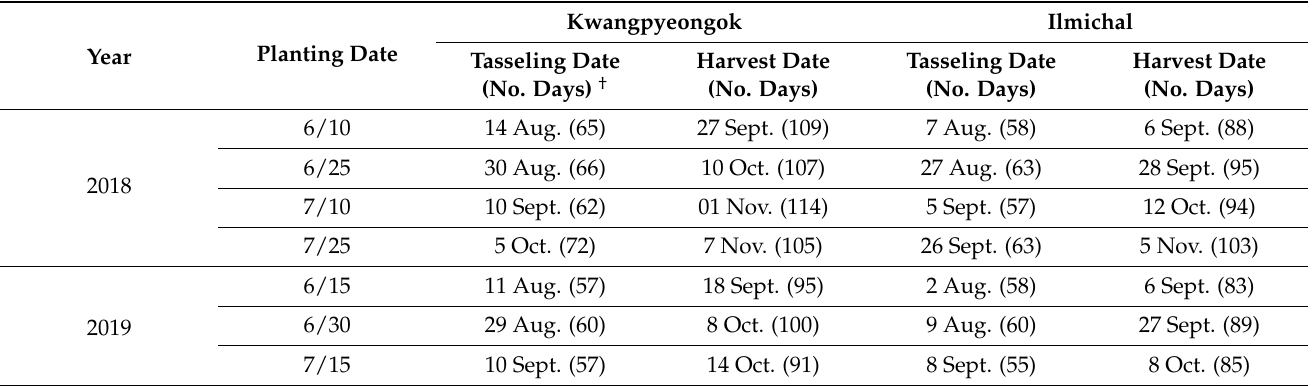
Table 8. Flowering (tasseling) and harvest dates of two maize cultivars (Kwangpyeongok